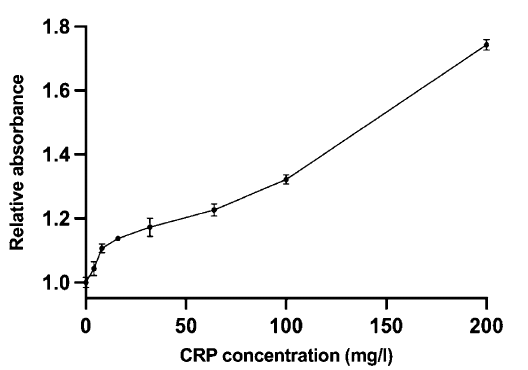
Figure 5. The CRP measurements with absorbance after 1 h of incubation in physiological saline. The relative absorbance is increasing as a function of CRP concentration. Error bars are the coefficient of variance % of absorbance from three replicate